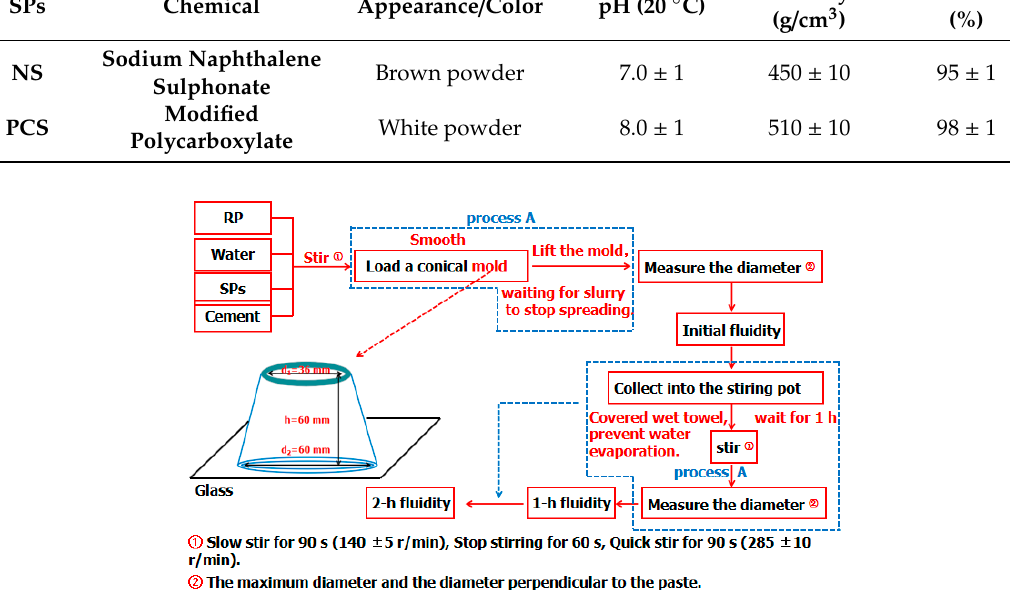
Figure 3. Experimental process of the RP impact on the cement and superplasticizer (CCS).